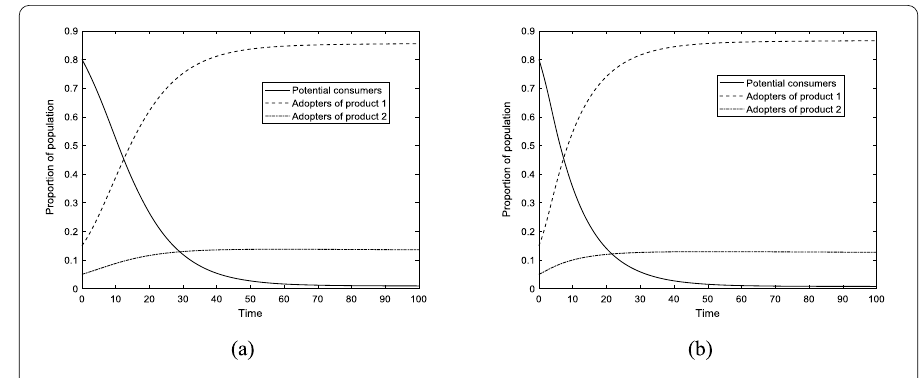
Figure 7 Diffusion curve of two products coexisting and persistently diffusing with considering advertising strategy when r 1 = 3 and r 2 = 2,